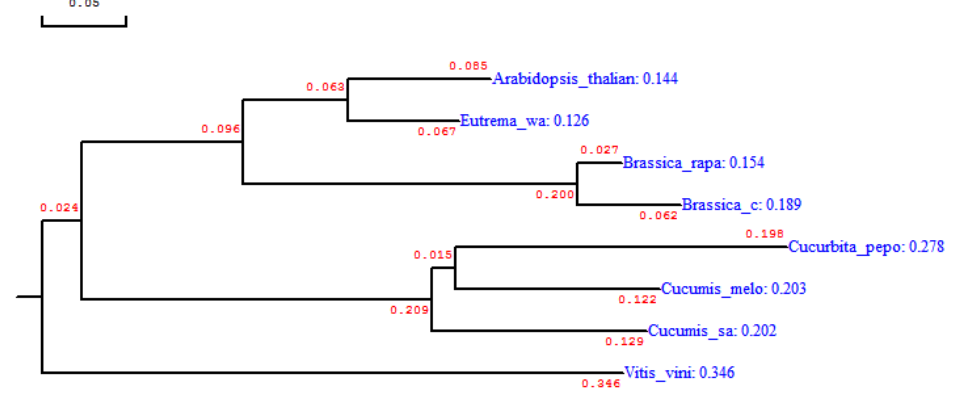
Fig. 5: Phylogeny tree base on distance matrix of Cucurbita pepo Partial PR 1 cds and seven other plants.